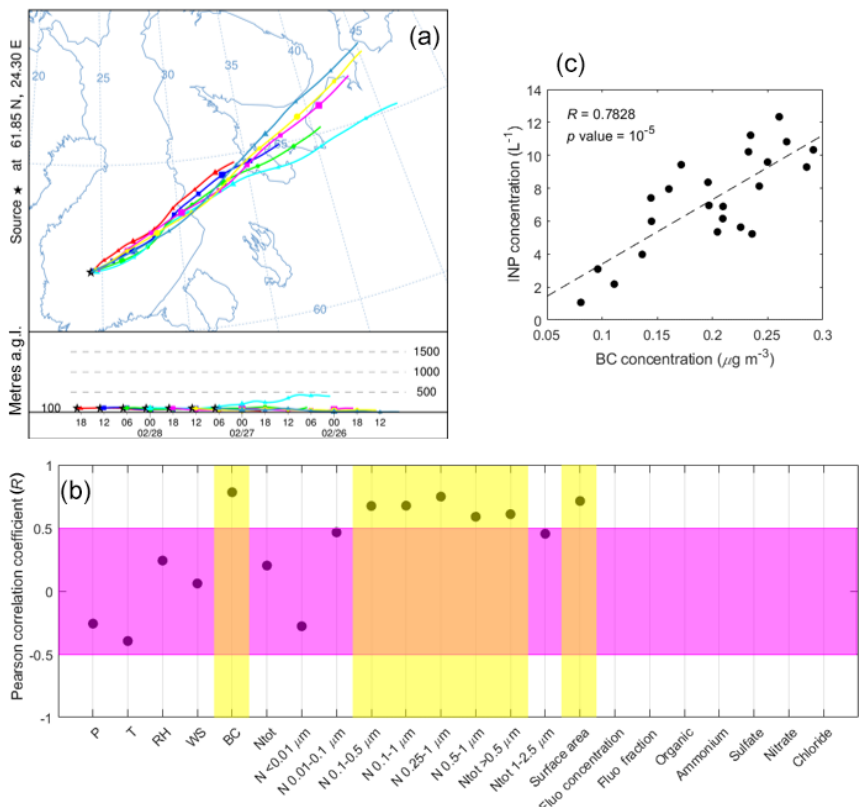
Figure 5. All results shown for 27–28 February 2018. (a) Backward trajectories calculated using the HYSPLIT model, extending 48h back in time. (b) Pearson correlation coefficients of the linear correlation between the [INP] and various meteorological and particle parameters. Magenta shading denotes the area of weak, if any, correlation ( − 0 . 5 < R < 0 . 5). Yellow shading denotes parameters for which the correlation with the corresponding [INP] is better than weak ( R > 0 . 5) and statistically significant at the 95% confidence interval ( p value < 0 . 05). Neither WIBS nor L-ToF-AMS had begun operating during this time period. (c) The [INP] as a function of the BC concentration.